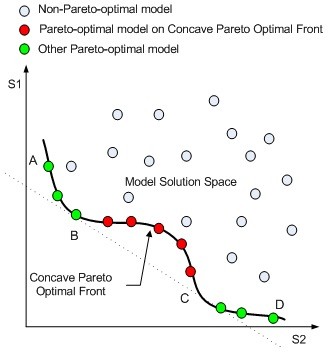
Deficiency of Regression-based Consensus Method. Pareto-optimal Models at the Concave Pareto Optimal Front Are Unreachable in a Regression-based Consensus Scoring Function